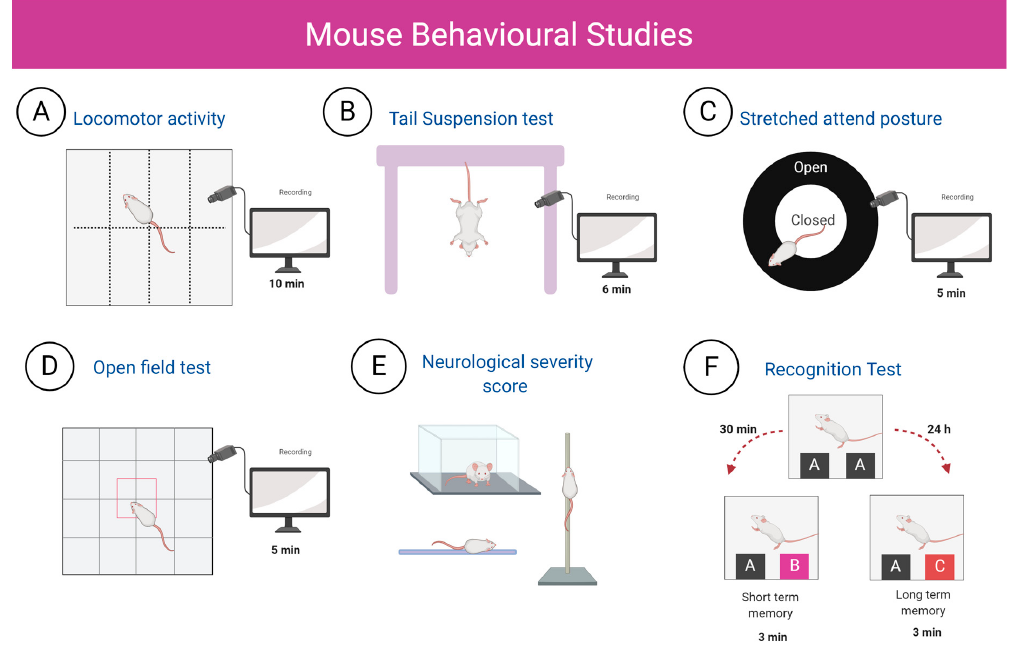
Figure 16. Schematic representation of the behavioural tests performed. Groups of mice of both experimental groups were tested only once, and the studies were performed during the first 4 h of the dark phase of the light cycle. ( A ) Locomotor activity. To assess LMA, the animals were placed in a box divided into 16 quadrants, and the number of crosses between quadrants were counted in 10 min. ( B ) Tail suspension test. In this test, the animals were suspended from the tail ventrally for 6 min, and the time that the animal presented behavioural despair was recorded. ( C ) Stretched attend posture. For this test, each mouse was located in the covered area of the platform and filmed for 5 min. The number of stretched attend postures was counted for 5 min. ( D ) Open field test, we videotaped from the top in a box divided into 16 quadrants by 5 min and evaluated the time spent in the outer area. ( E) Neurological severity score. ( F ) Recognition test. For this test, the animals were exposed to two objects A, and 30 min after, one of these was changed for object B, whereby short-term memory was evaluated; for long-term memory, the same procedure was carried out, but after 24 h, object C was presented to the animals. (Created with